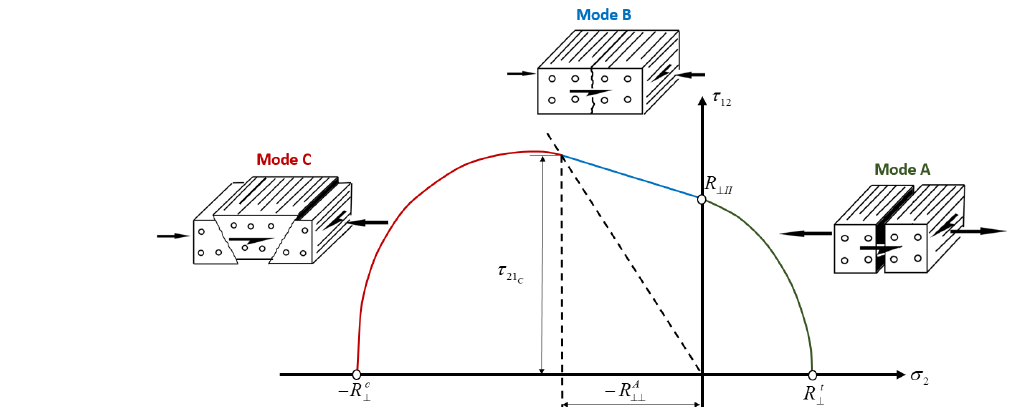
Figure 2. Failure envelope under biaxial loading (Knops, 2008).